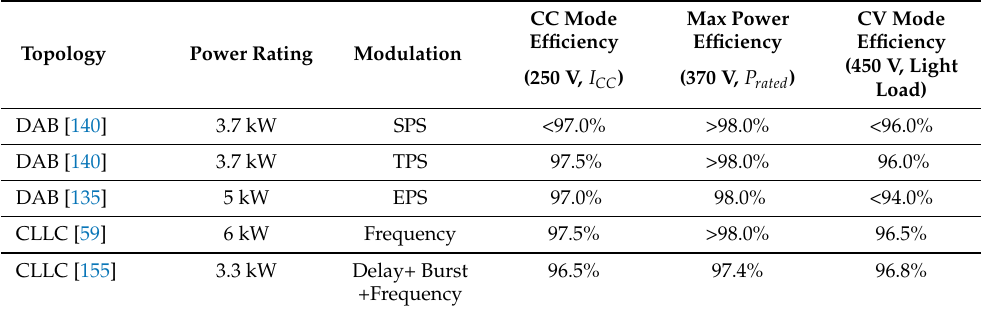
Table 12. Effect of modulation technique on the efficiency of DAB and CLLC topologies designed for 400 V EV charging applications (in G2V